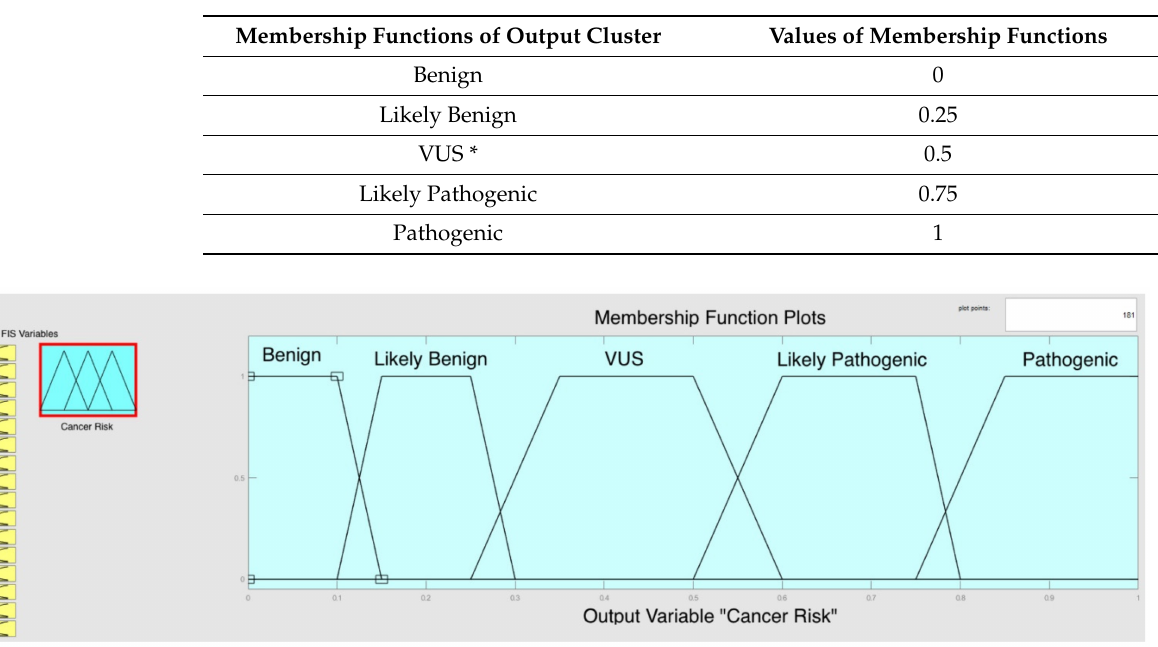
Figure 3. The generated appearance of the output cluster using fuzzy logic interface on the MATLAB. Small-merged yellow boxes illustrate sixteen parameters that were introduced as inputs. The blue box shows the output part and determines five different variant classifications as membership functions. The Y-axis presents membership functions of output which can be determine according to the output score. The X-axis presents values of membership function between